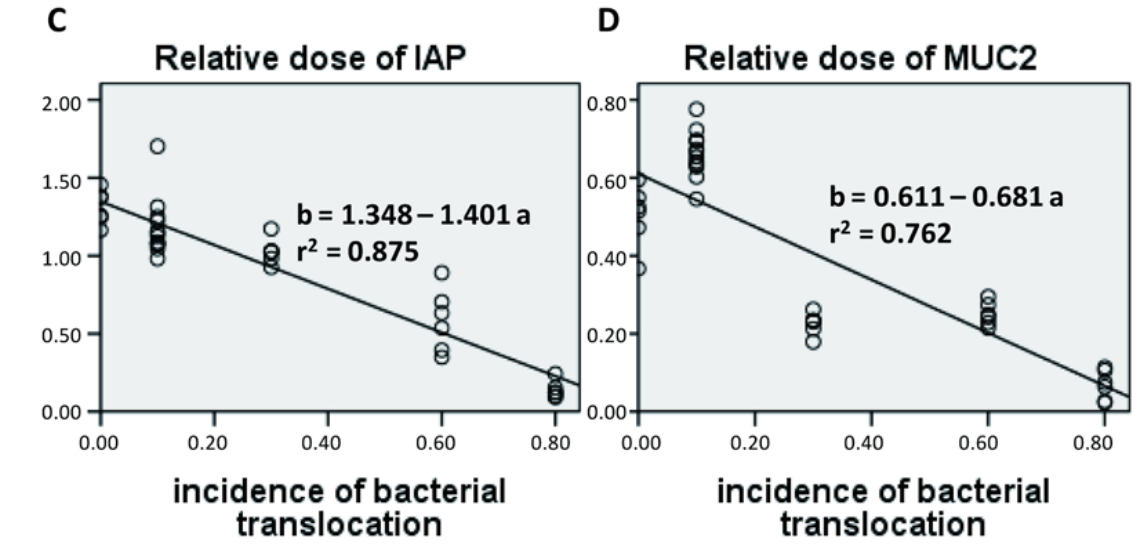
Figure 8. Regression analysis of bacterial translocation and some other defensive components. ( A ) Number of goblet cells; ( B ) Relative dose of lysozyme; ( C ) Relative dose of intestinal alkaline phosphatase (IAP); ( D ) Relative dose of mucin 2 (MUC2). n = 36 for each analysis.